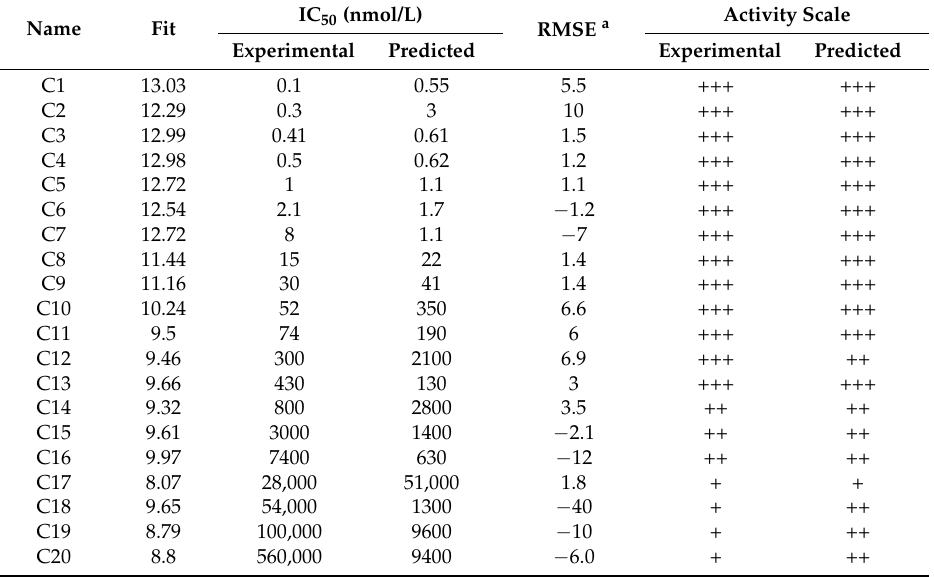
Table 2. Experimental and predicted activity values of training set compounds according to Hypo